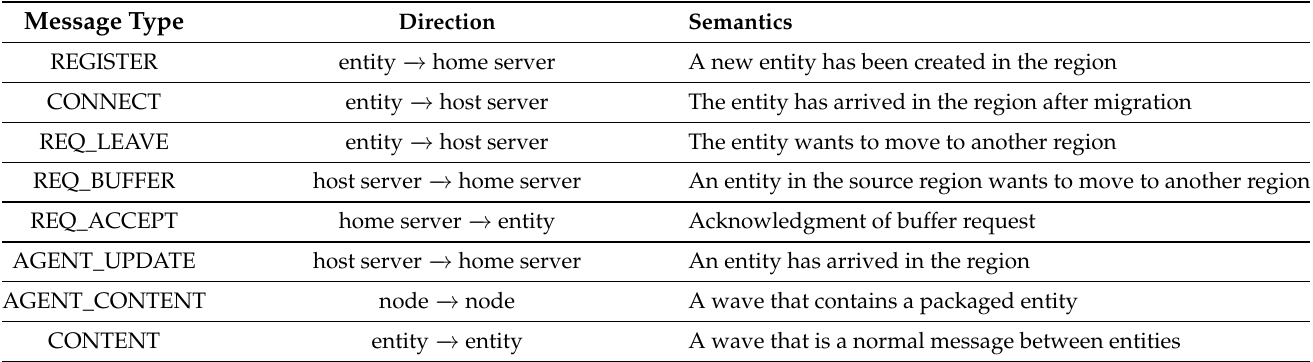
Table 2. Types of waves sent between entities in the system in the context of the migration of an entity between two host regions, different from its home region.